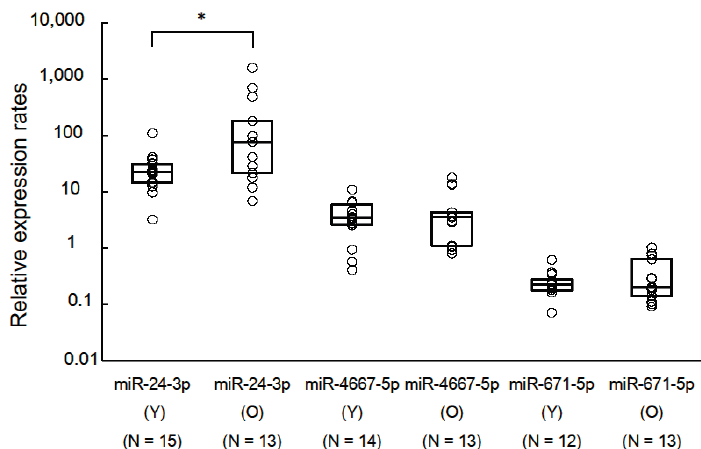
Figure 1. Comparison of relative expression rates of candidate miRNAs for aging biomarker between young and old groups. We performed TaqMan RT-qPCR to calculate the relative expression rates of three candidate miRNAs between young and old groups. We used miR-4739 as internal control miRNA. Circle plots represent relative expression rates of each sample. The horizontal lines within each box represent the 25, 50 and 75th percentiles.